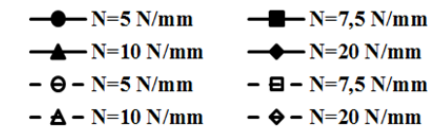
Figure 6. Influence of wear on the angles of the tribocontact